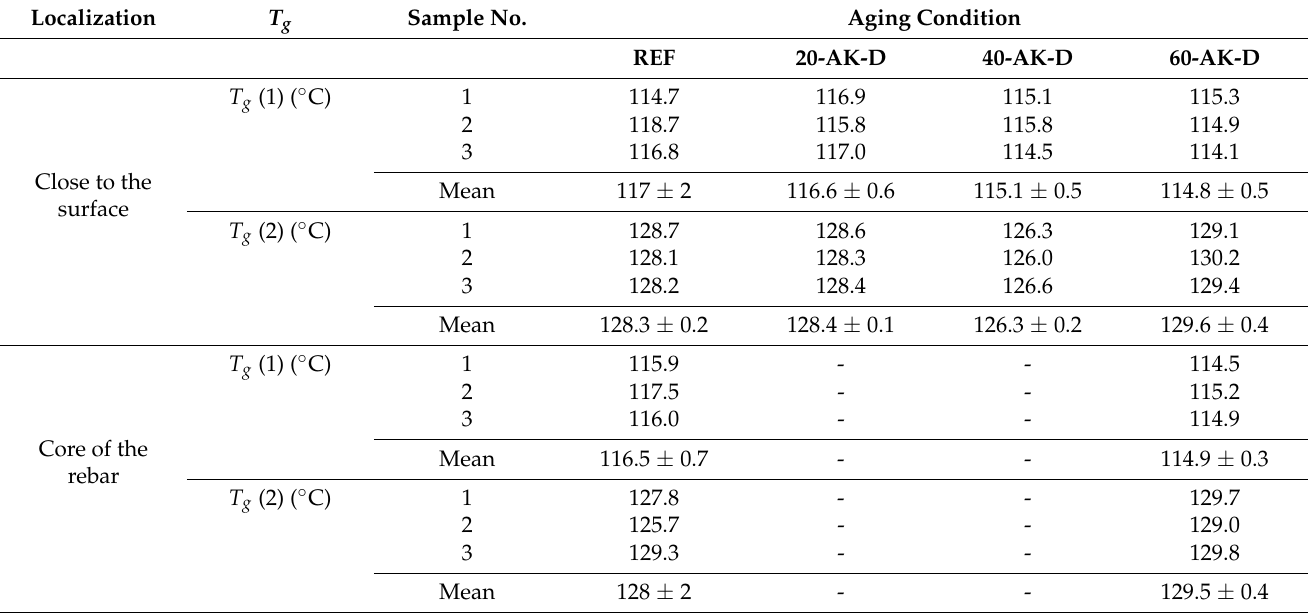
Table 5. Values of the glass transition temperature determined by DSC analyses on reference GFRP rebars (REF) and on rebars exposed for 240 days to direct immersion in the alkaline solution at various temperatures. Values obtained at first and second runs are reported ( T g (1) and T g (2)).